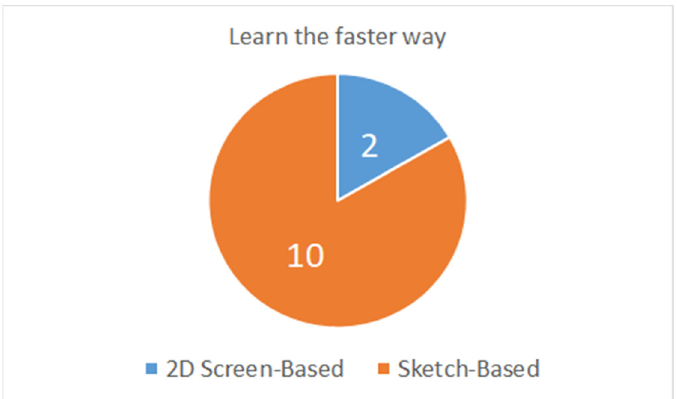
Figure 14. A result showing which tool was learned to be used faster.